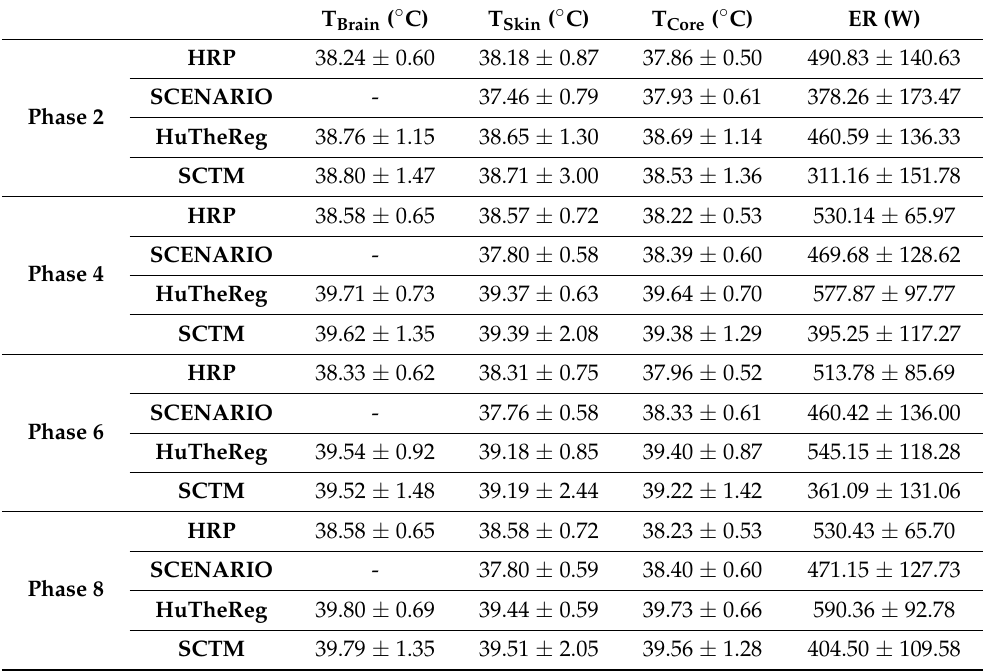
Table 5. Mean and standard deviation values for stressful working profile